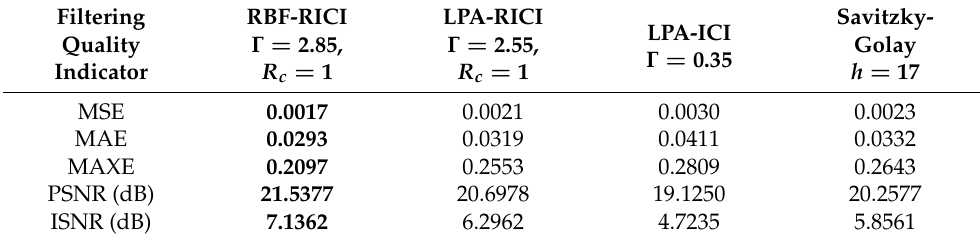
Table 17. Doppler signal (SNR = 10 dB)—Filtering